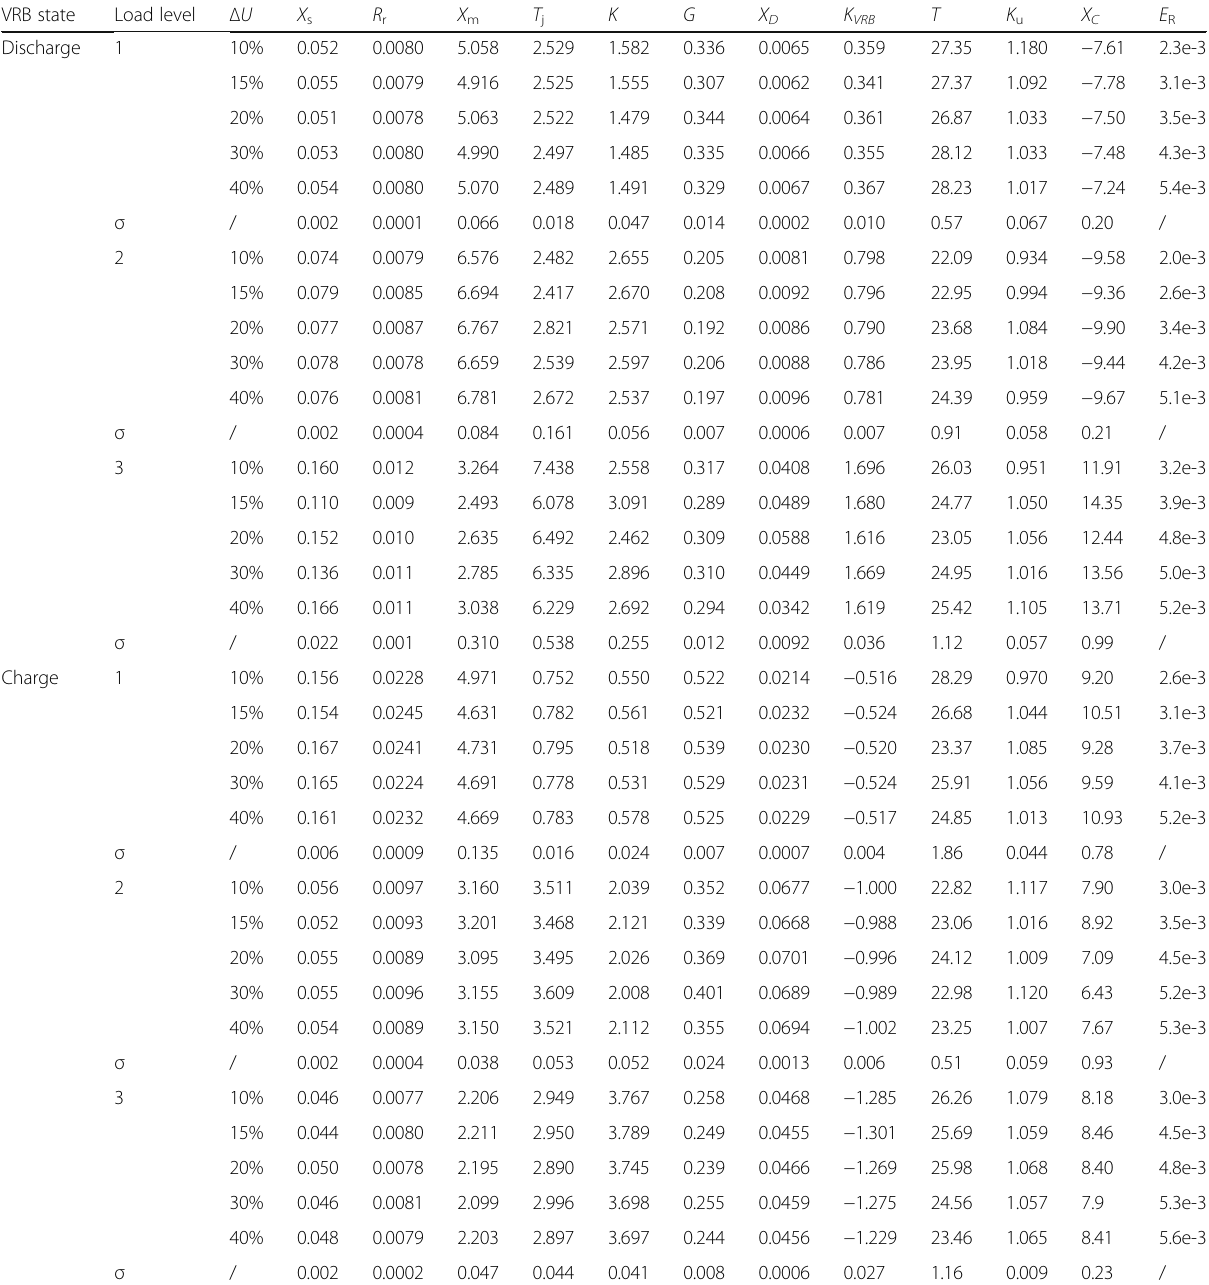
Table 5 Recognition results of generalized synthesis load model parameters VRB state Load level Δ U Discharge